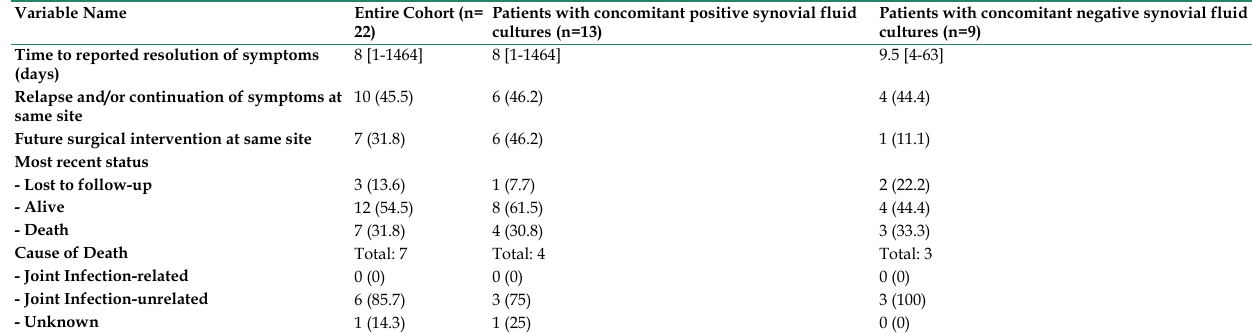
Table 4. Outcomes of Patients with Prosthetic Joint and CPPD Documentation Variable